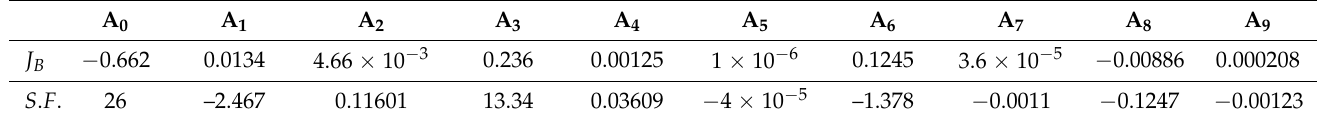
Table 4. The coefficients in Equations (4) and